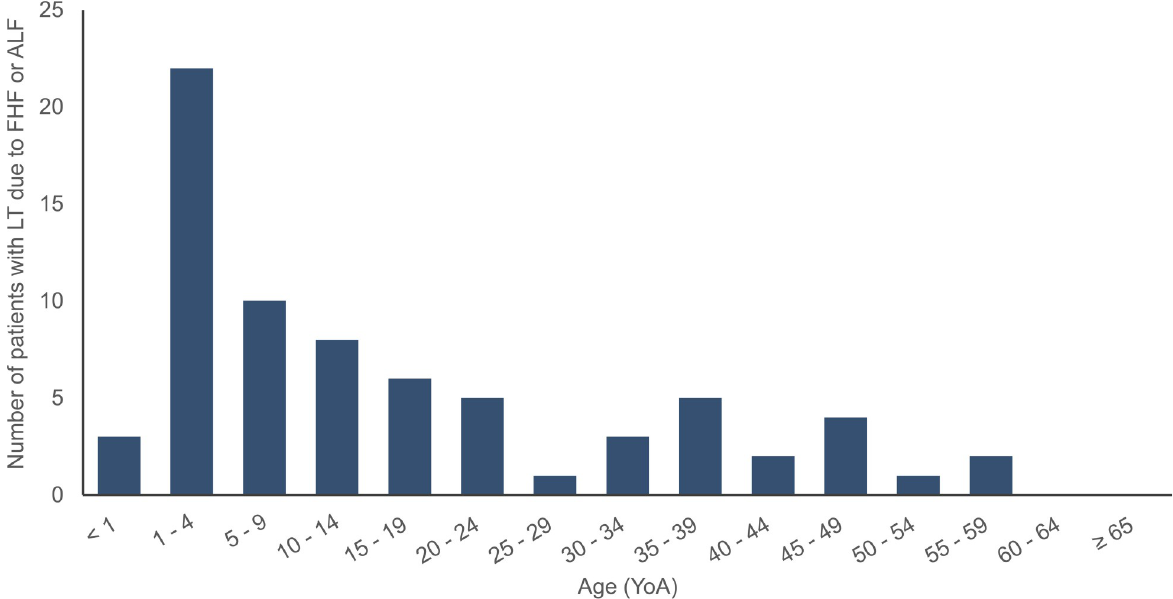
Fig 5. Total sum of patients with LT due to FHF or ALF by age group in Mexico throughout the observation period (2007–2019). ALF: Acute liver failure; FHF: Fulminant hepatic failure; LT: Liver transplant; YoA: Years of age.